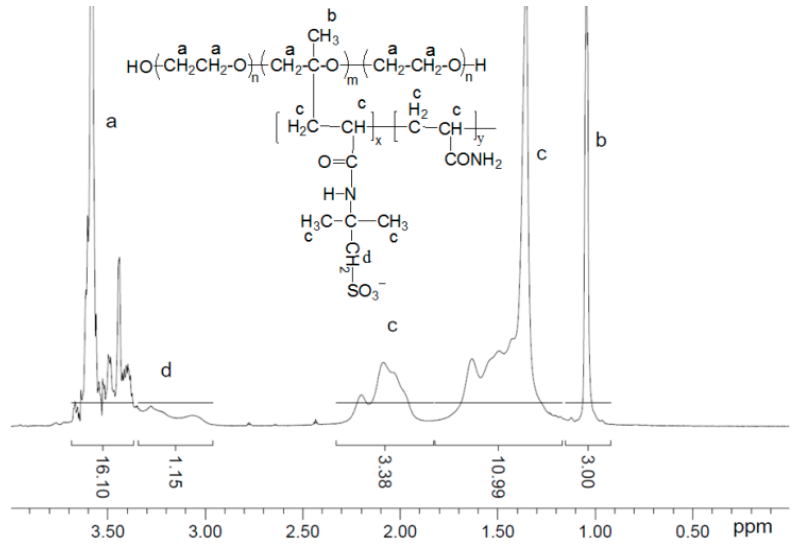
Figure 3. 1 H NMR spectrum of the polymer S3.